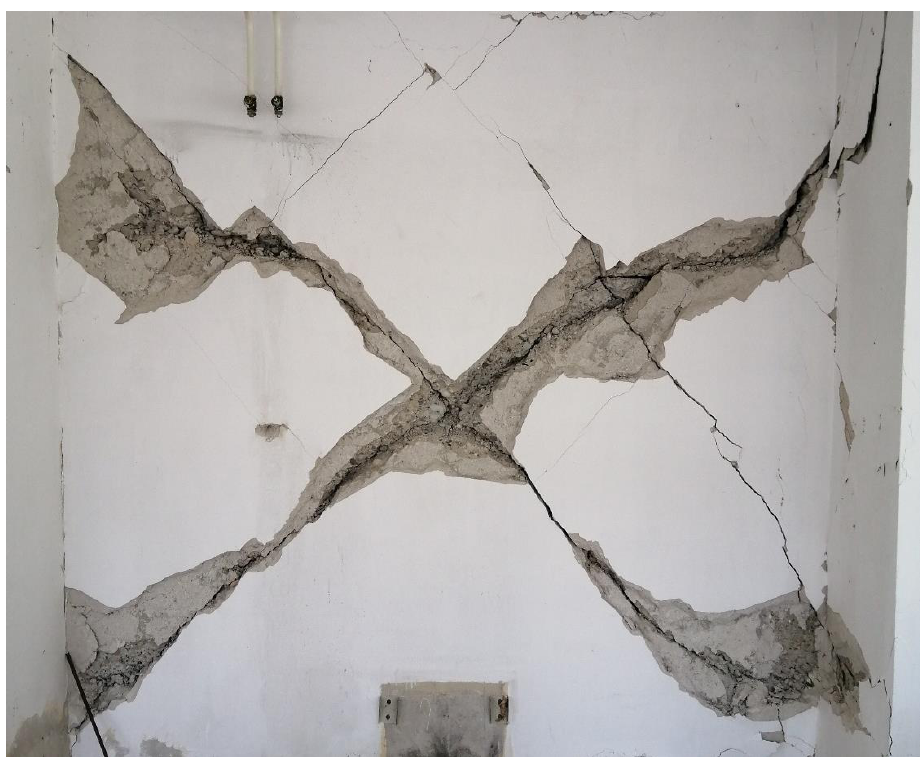
Figure 2. Diagonal cracks in the lightly reinforced RC shear wall.